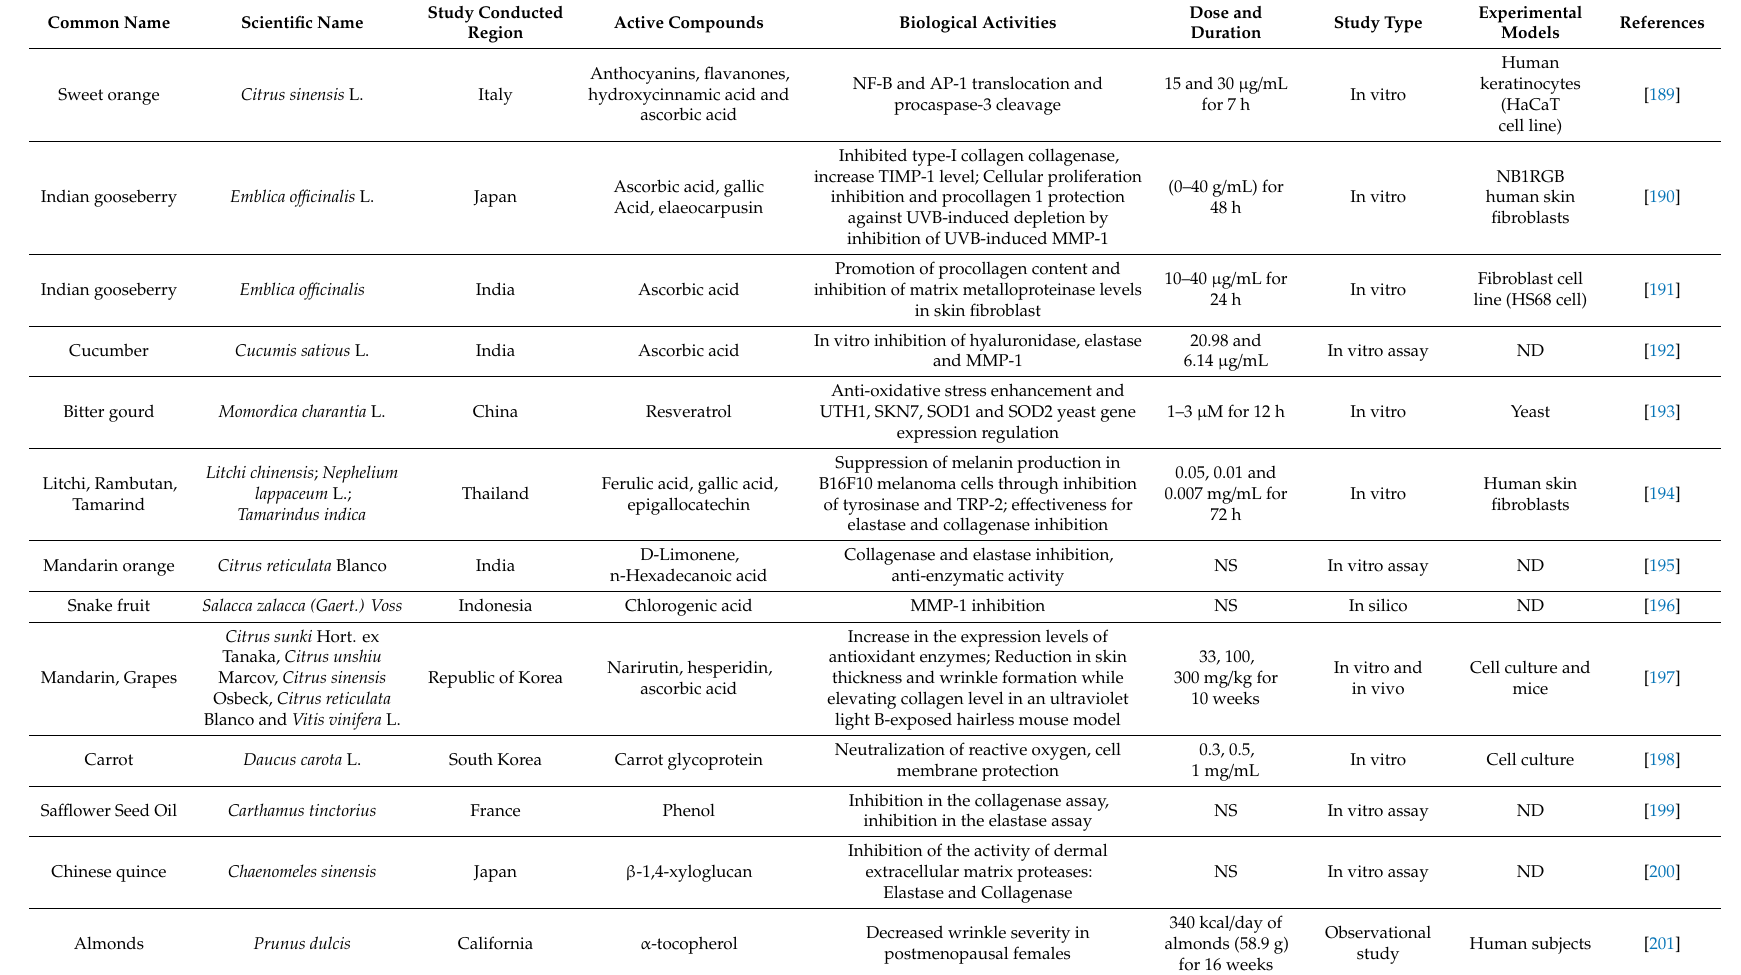
Table 1. Fruits and vegetable extracts and their phytochemicals with antiageing e ff